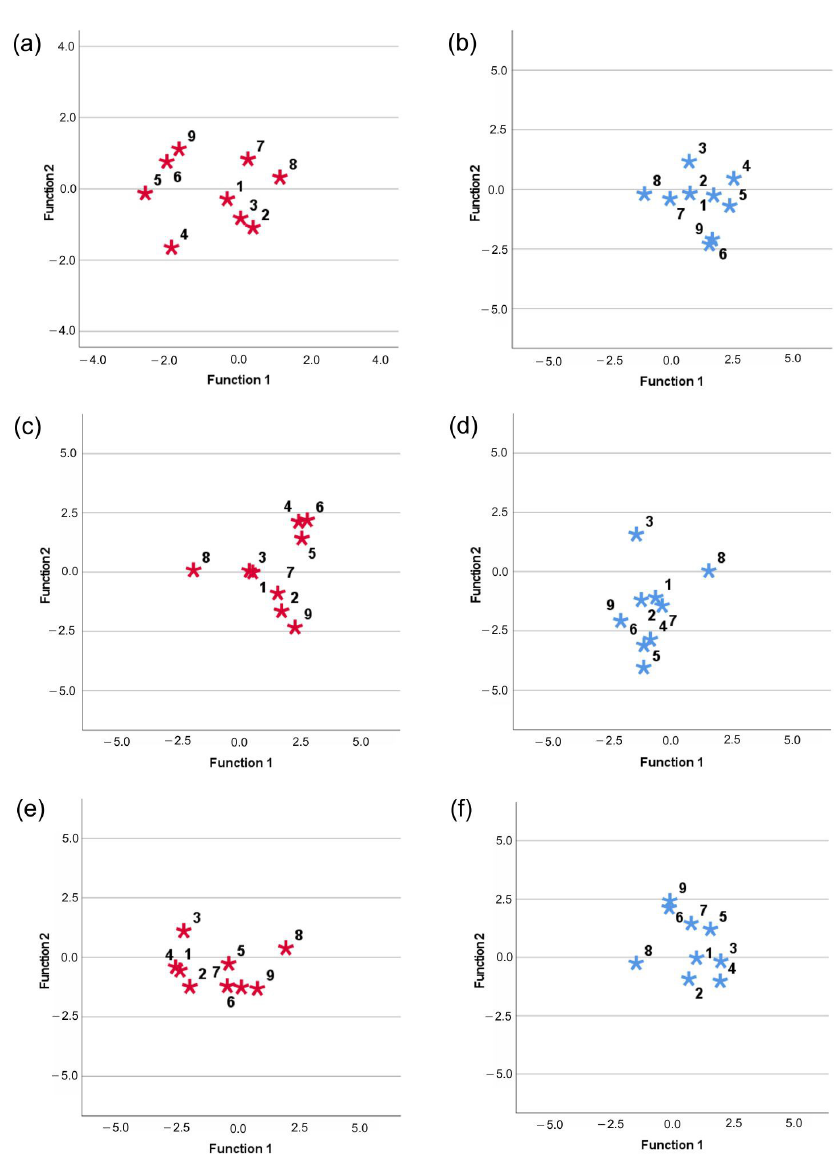
Figure 4. Scatterplots of the CVA of the three structures. The sexes were examined separately. Between brackets, the percentage of original cases correctly classified: ( a ) female head (57.2%); ( b ) male head (72.3%); ( c ) female pronotum (86.7%); ( d ) male pronotum (85.0%); ( e ) female elytron (78.2%); ( f ) male elytron (74.8%). The numbers in each plot correspond to the Platynus species: 1 = P. complanatus ; 2 = P. depressus ; 3 = P. erythrocephalus ; 4 = P. maritimus n. sp. ; 5 = P. occitanus n. sp. ; 6 = P. peirolerii ; 7 = P. simonisi n. sp. ; 8 = P. teriolensis ; 9 = P. vignai n. sp. Red star = centroid of female data, blue stars =centroid of male data.